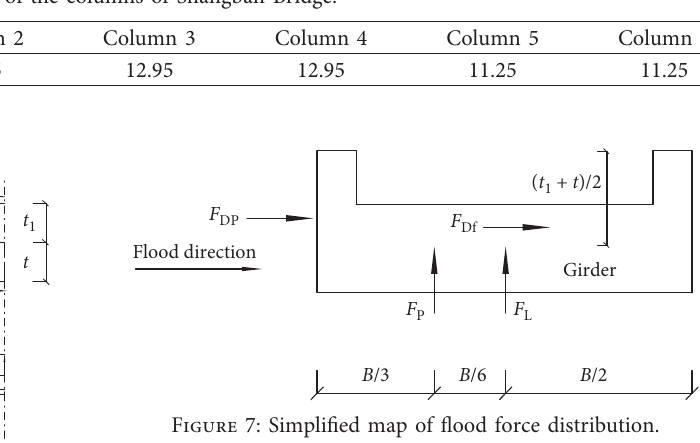
Table 2: Height of the columns of Shangban Bridge.